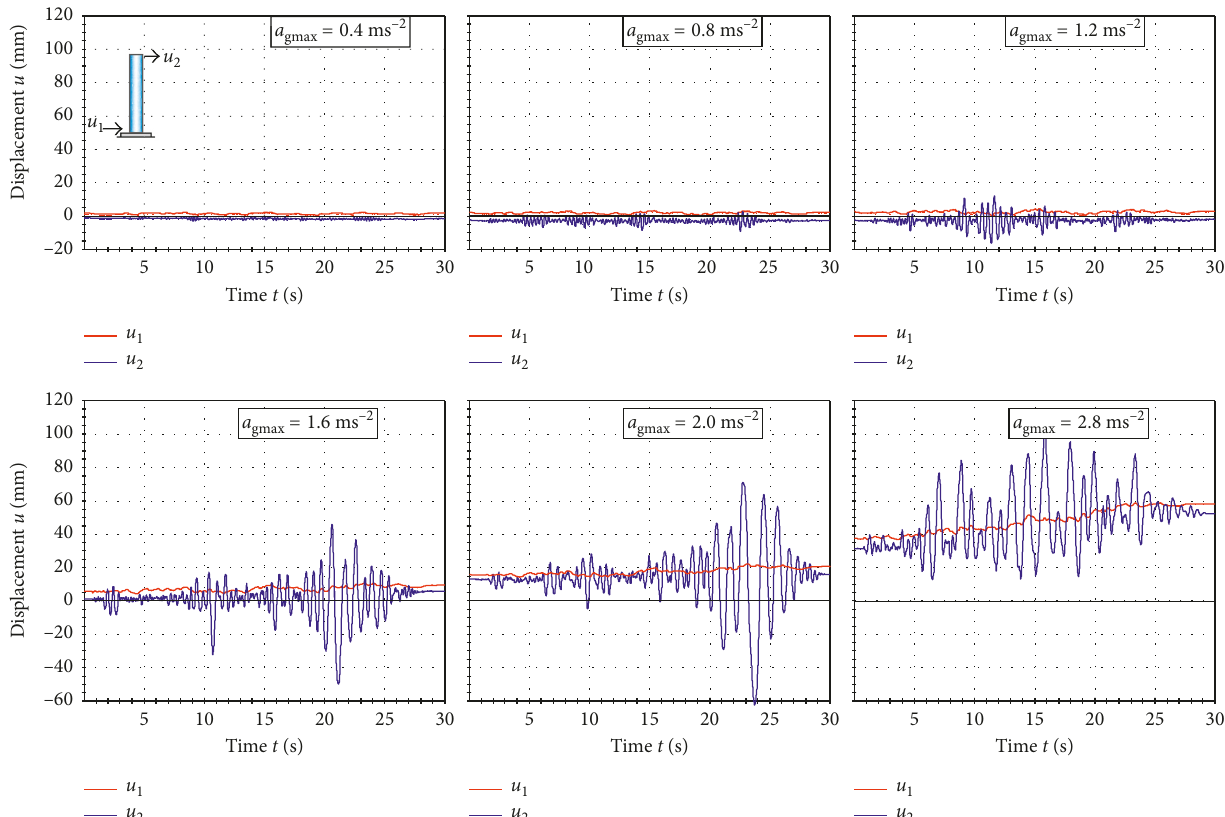
Figure 7: Horizontal displacements u 1 and u 2 of the column S1 for the artificial accelerogram at some a gmax .